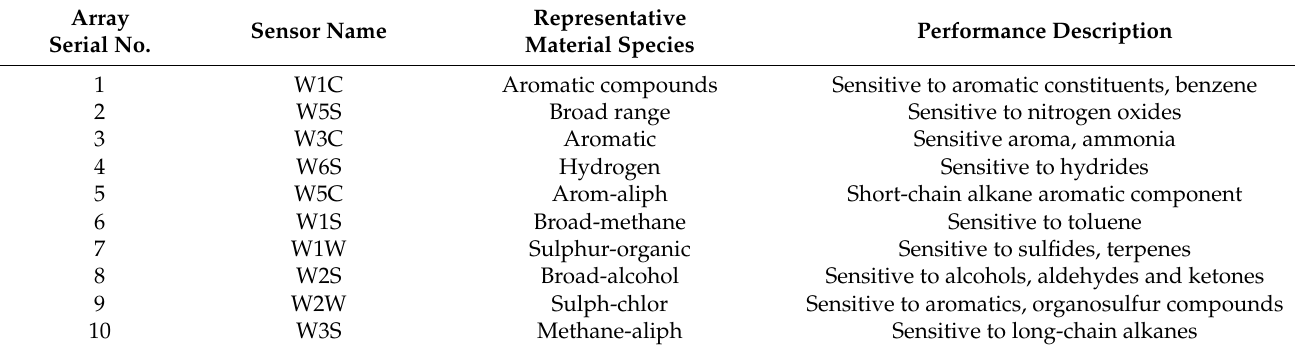
Table 1. E-nose sensors and their main application in